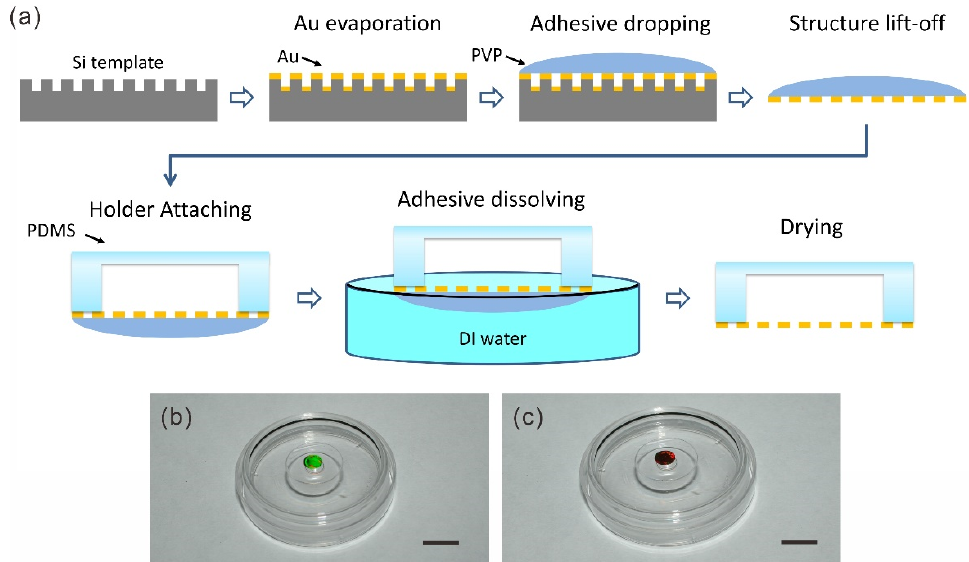
Figure 1. ( a ) Schematic of fabrication process of freestanding metal nanostructures with PVP adhesive: Au deposition, dropping PVP adhesive on the nanostructures, adhesive lift-off, attaching holder, dissolving adhesive in water, and drying freestanding nanostructures. Freestanding Au nanomembrane ( b ) and nanowires ( c ) on the PDMS holder in a Petri dish. Scale bars: 1 cm in ( b , c